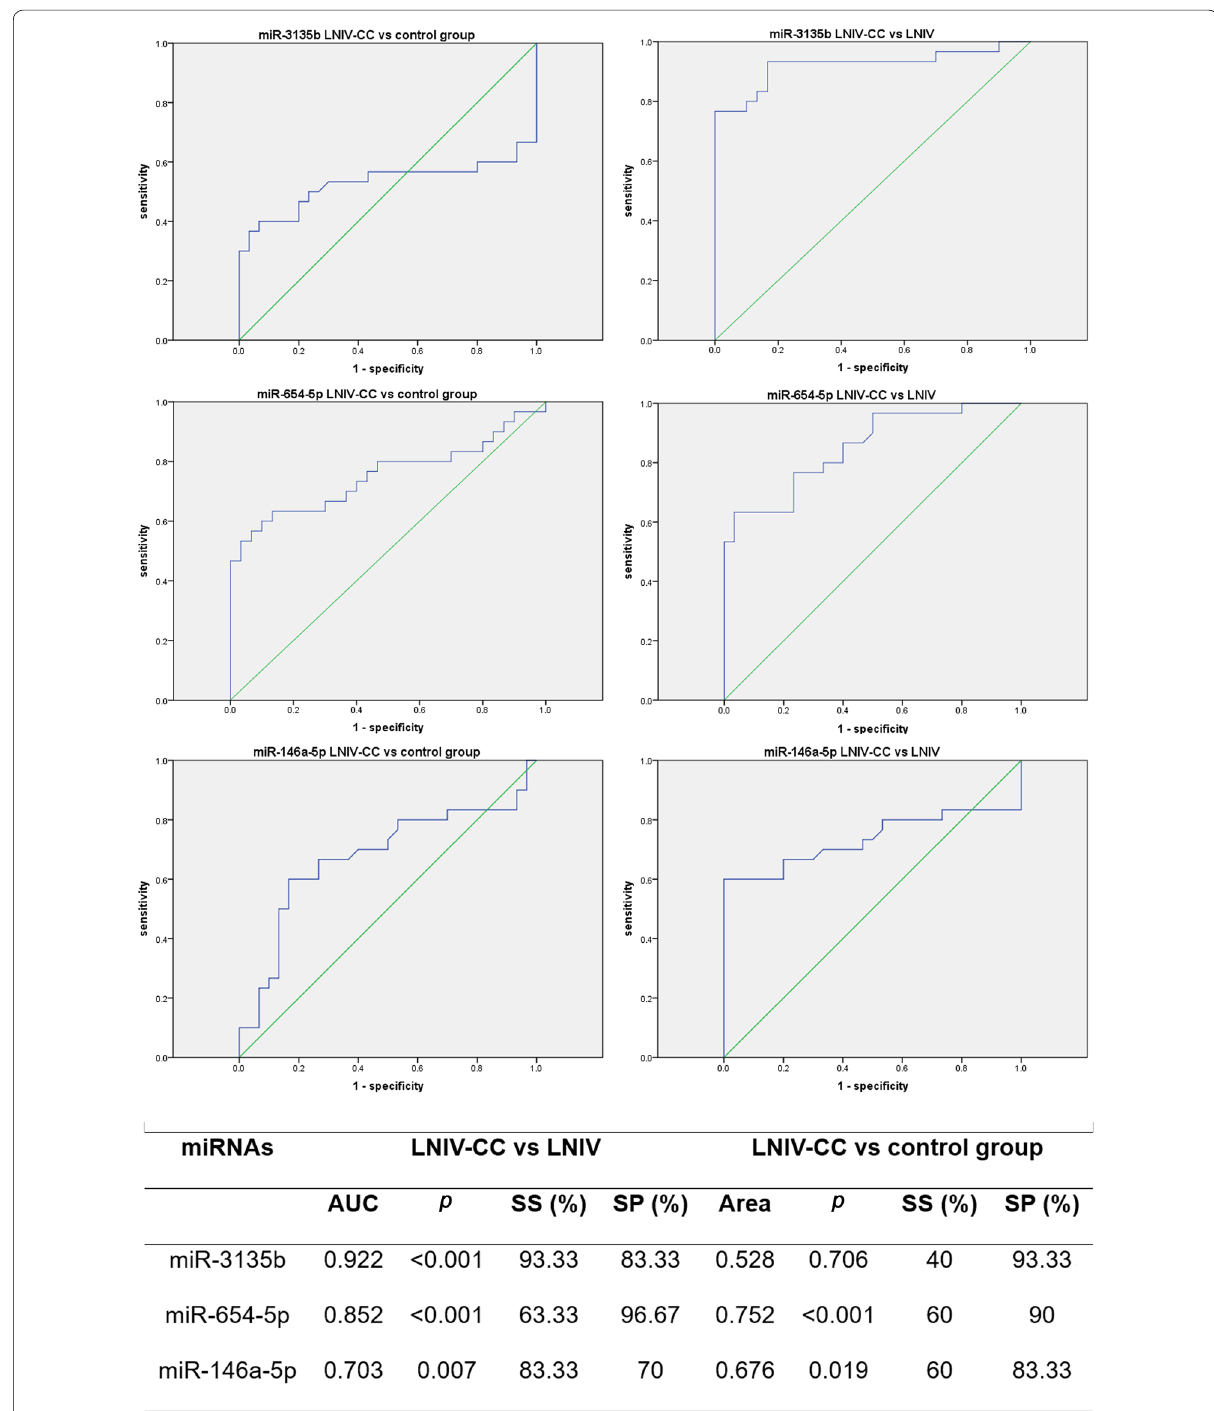
Fig. 8 ROC curve for the validated